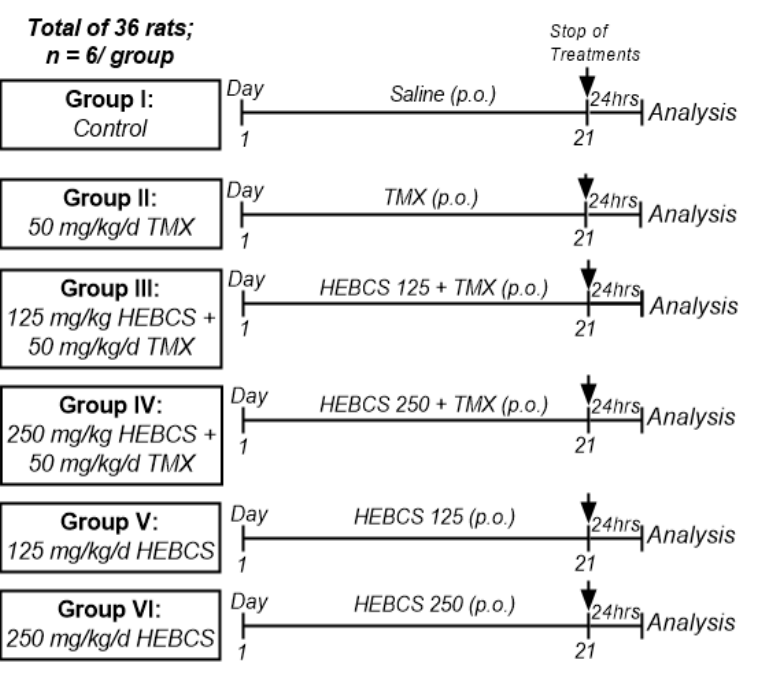
Figure 3. Experimental protocol. HEBCS, hydroethanolic extract of (defatted) B. coriacea seeds; TMX, tamoxifen.